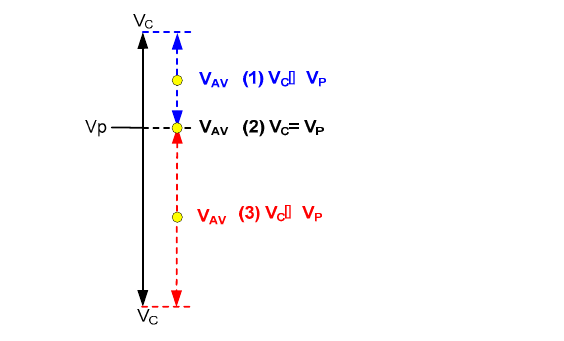
Figure 10. Case adaptation-analysis of a single type of sensor.